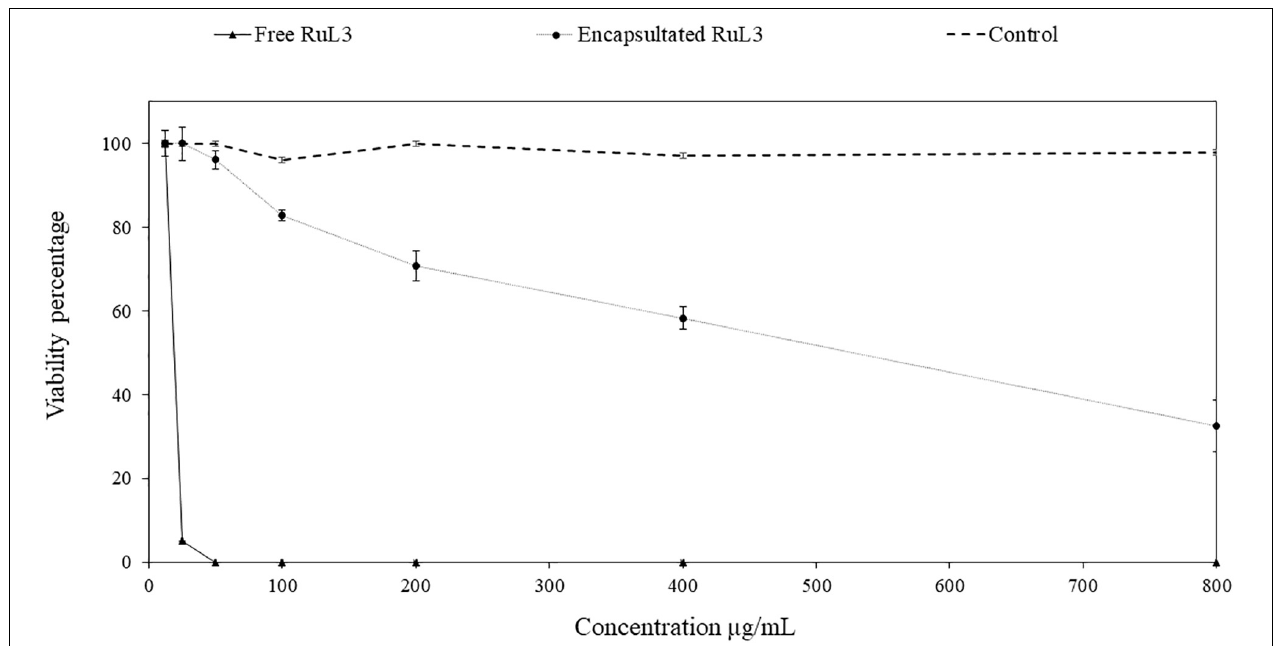
FIGURE 7 | HeLa cell viability percentage after 24-h exposure to concentrations (between 12.5 and 800 µ g/ ml) of free and microencapsulated RuL3. The control represents the spray-dried microcapsules without RuL3 (empty capsules). Data are presented as means ( ± SD) of three independent repeats in